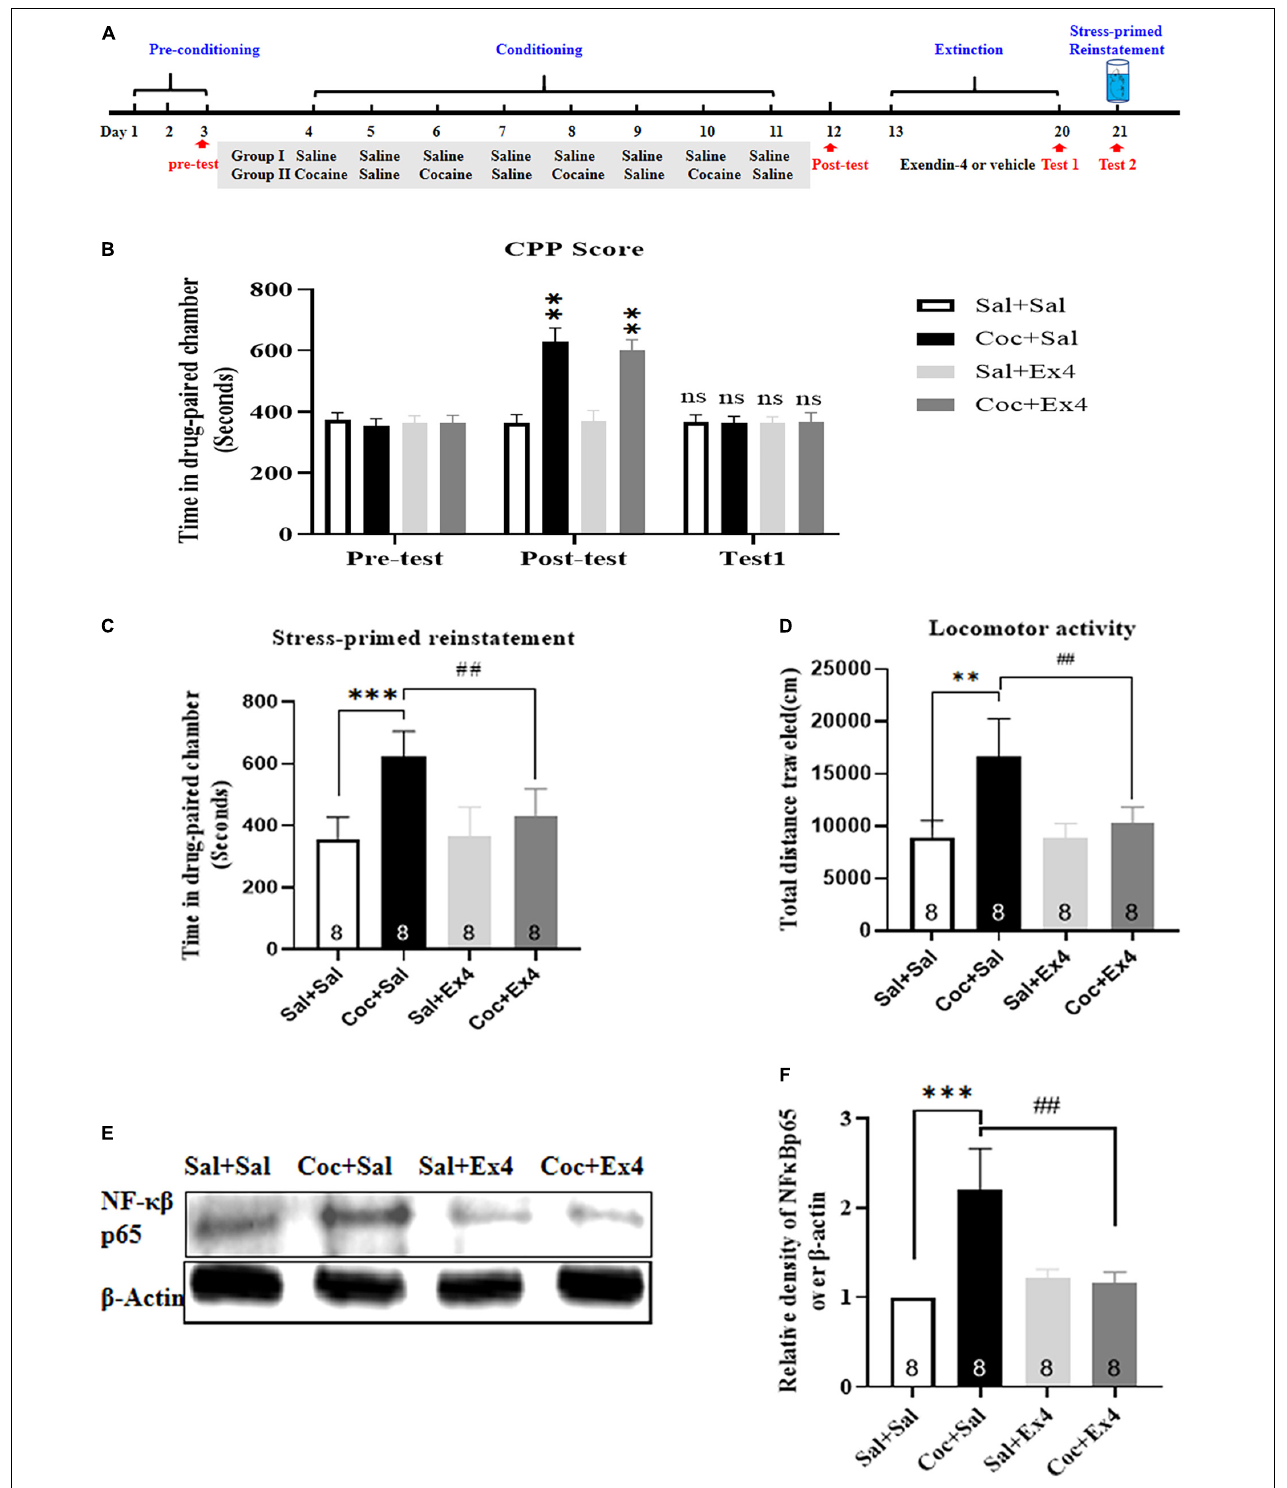
FIGURE 2 | The systemic pretreatment with exendin-4 blocked stress-induced reinstatement of cocaine-induced CPP. (A) The experimental schedule for Swim, saline as well as cocaine and exendin-4 treatments. (B) After cocaine conditioning, animals developed a robust room preference for the cocaine-paired compartment. ∗∗ represents p < 0.01 vs Sal + Sal group, n = 8 each group, two-way rmANOVA. Additionally, CPP scores after vehicle or exendin-4 administration suggested that the cocaine-induced CPP was completely extinguished after 8 days extinction training. ns represents no significant difference, n = 8 each group, two-way rmANOVA followed by Dunnett’s multiple comparisons test. (C) The systemic pretreatment of exendin-4 significantly blocked stress-induced reinstatement